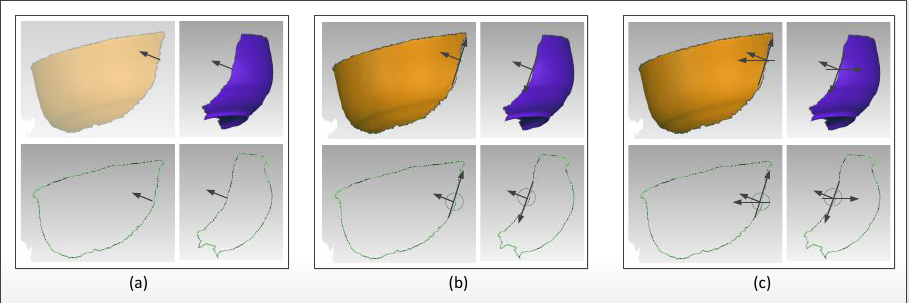
Figure 3. To Establish the Local Cartesian